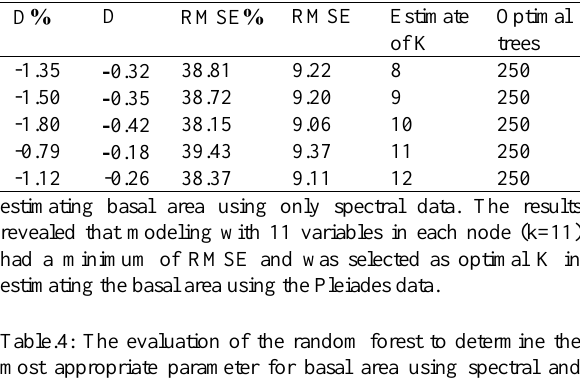
Table 5 represents applying spectral and auxiliary data in comparison with applying only spectral data in estimating both volume